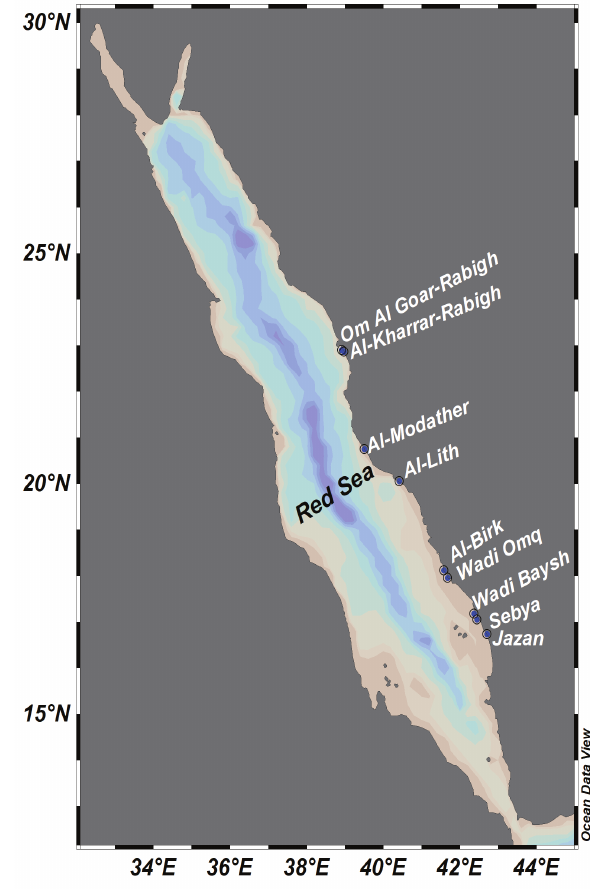
Figure 1: The map of the nine sampling locations of mangrove swamps along the Red